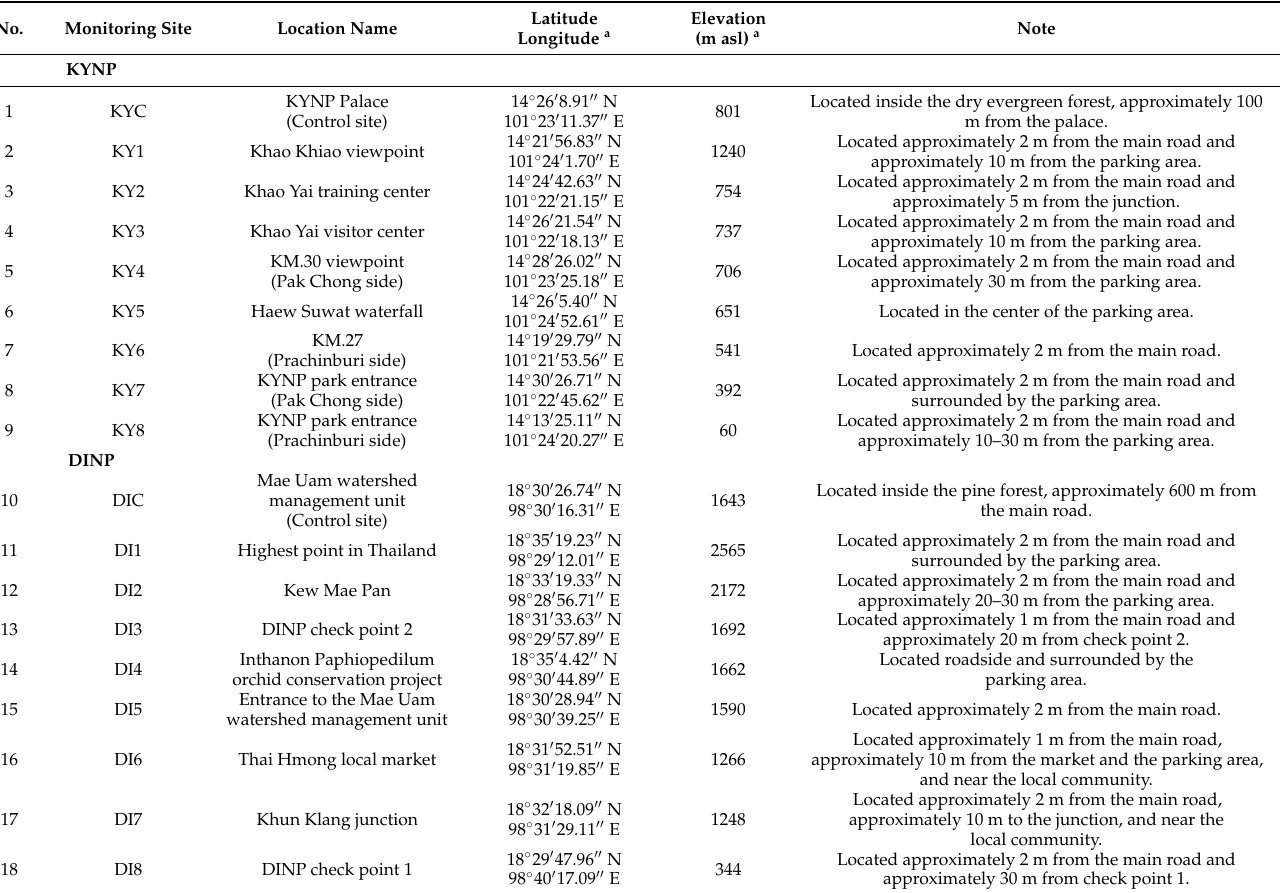
Table 1. Descriptions of the control (KYC, DIC) and monitoring (KY1–KY8, DI1–DI8) sites in Khao Yai National Park (KYNP) and Doi Inthanon National Park (DINP) in Thailand.